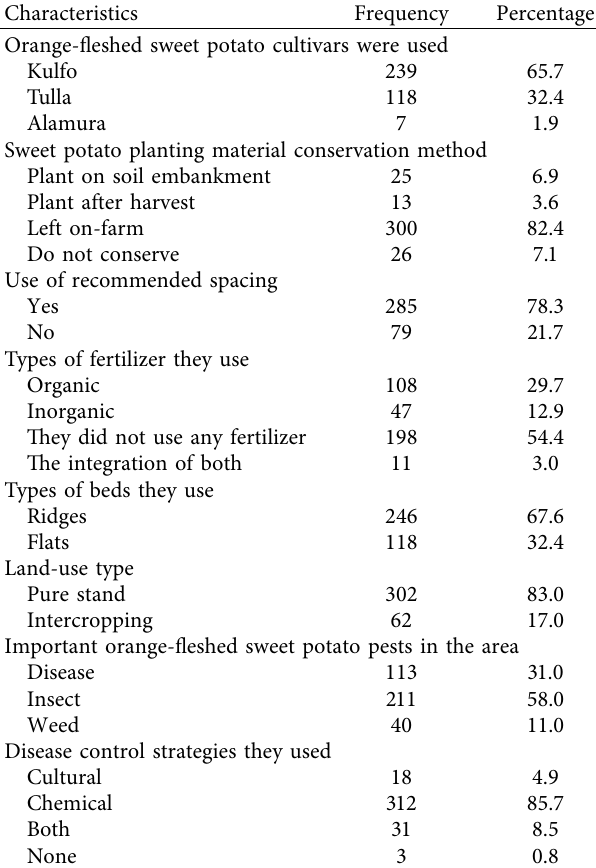
Table 3: Sweet potato production management in the study